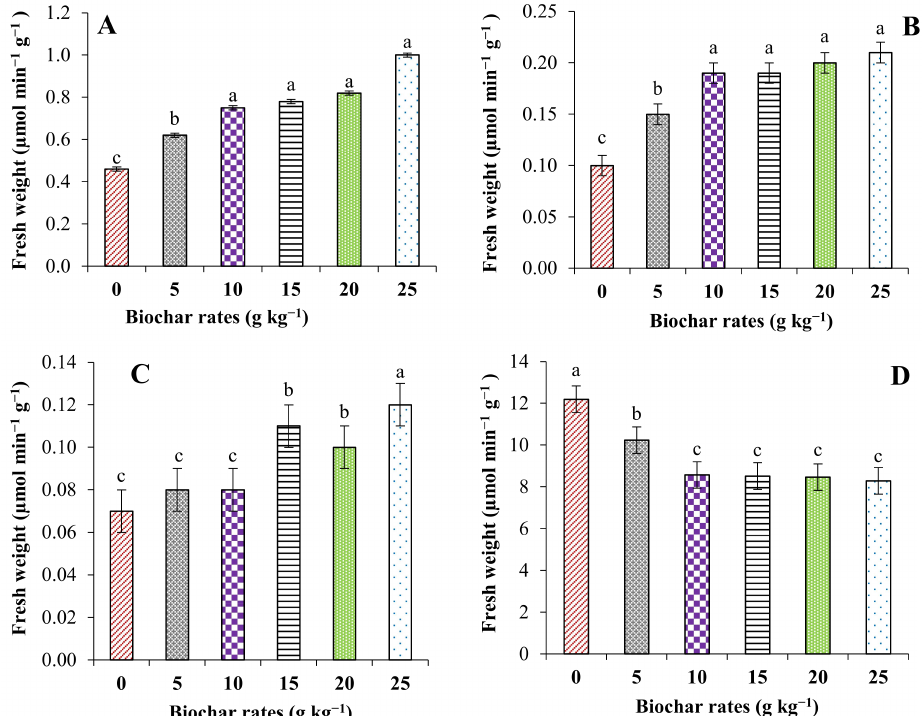
Figure 1. Effect of SWB on the activities of some antioxidant enzymes. ( A ): ascorbate peroxidase, ( B ): polyphenol oxidase, ( C ): pyrogallol peroxidases), and ( D ): malondialdehyde. The results are based on the fresh weight. Means ( ± SE) followed by different letters are significantly different according to Tukey’s test ( p ≤